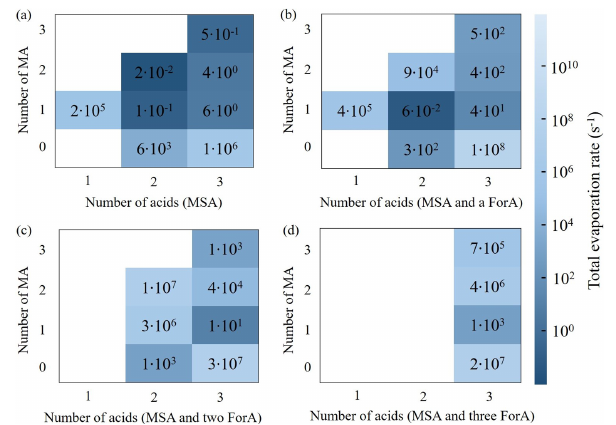
Figure 4. Calculated effective evaporation rates (s − 1 ) of the (MSA) x (MA) y (ForA) z (0 ≤ y ≤ x + z ≤ 3) clusters at 278.15K. (a) Without ForA monomer, (b) containing 1 ForA monomer, (c) con- taining 2 ForA monomers, and (d) containing 3 ForA